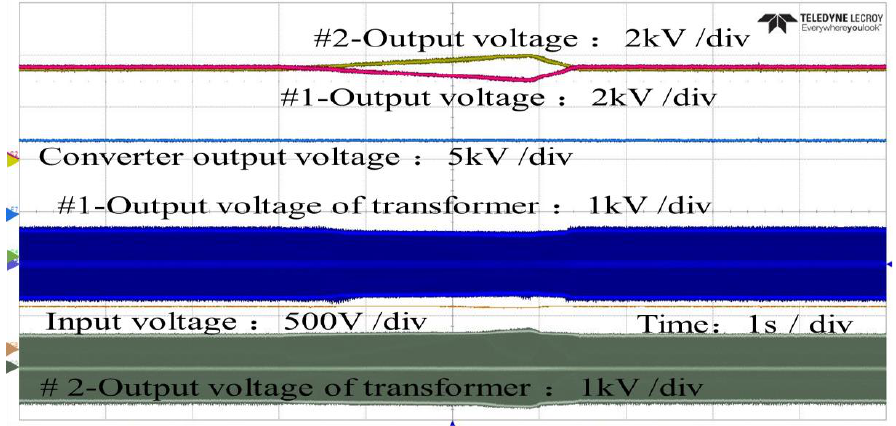
Figure 21. Output voltage with different K sh .